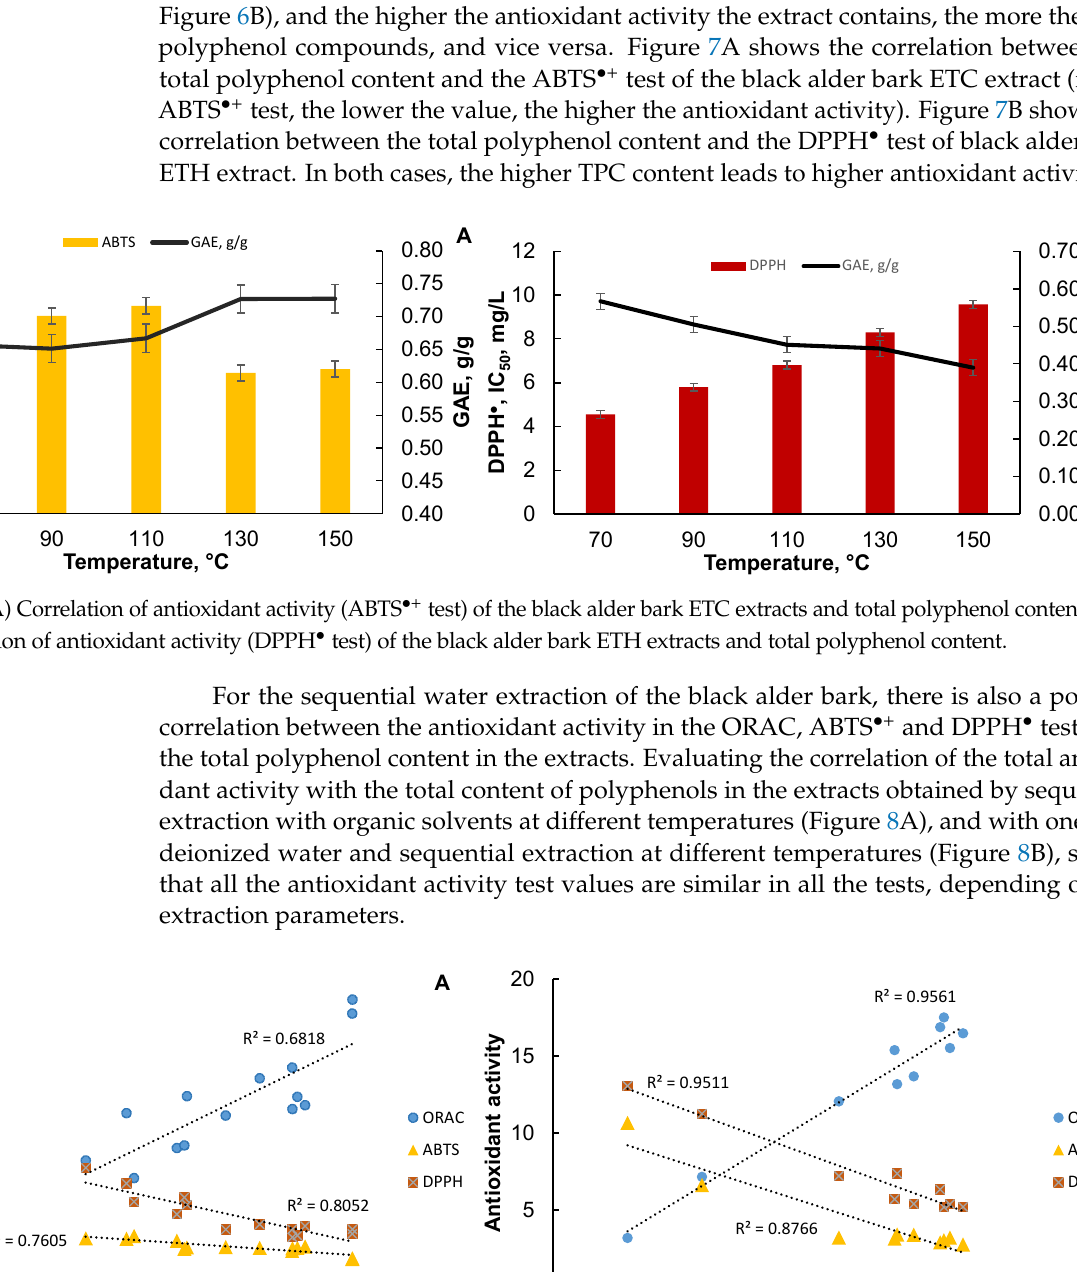
Figure 6. ( A )Antioxidant activity (ORAC test) of the black alder bark ETC and ETH extracts and ( B ) the correlation be- tween the antioxidant activity (ORAC test) of ETC extracts of black alder bark and total polyphenol (TPC) content. Data is shown as mean ( n = 4) values ± standard deviation. For ( A ) Kruskal–Wallis test, p < 0.05.